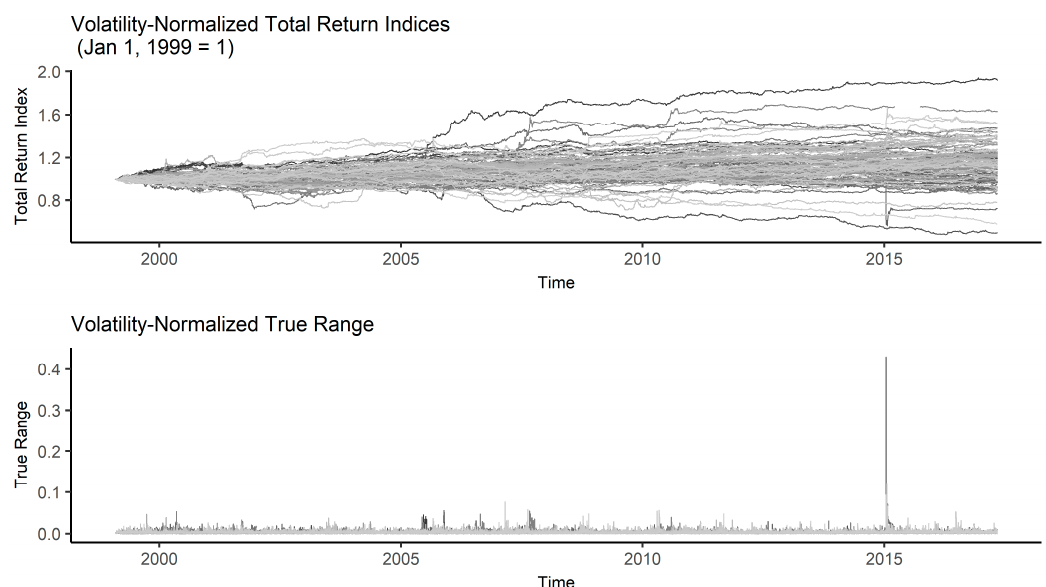
Figure 4. Global futures volatility normalized return indices and true range.